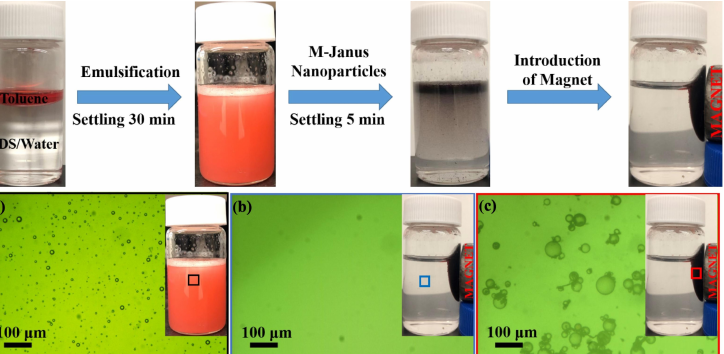
Figure 7. Phase separation process of SDS stabilized toluene-in-water emulsions with the addition of M-Janus nanoparticles under the external magnetic field (top row), and micrographs of the SDS stabilized toluene-in-water emulsion droplets (down row). ( a ) Stable tiny toluene droplets before the phase separation. ( b ) Clear water phase after the phase separation and ( c ) M-Janus nanoparticle- tagged toluene droplets after the phase separation. The scale bars are 100 µm. Reproduced with permission [128]. Copyright 2019, Elsevier